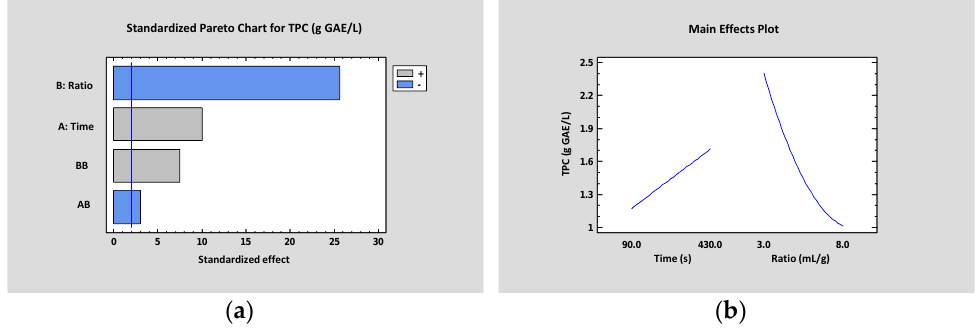
Figure 1. Standardized Pareto Chart ( a ) and Main effects Plot ( b ) for TPC (g GAE/L).